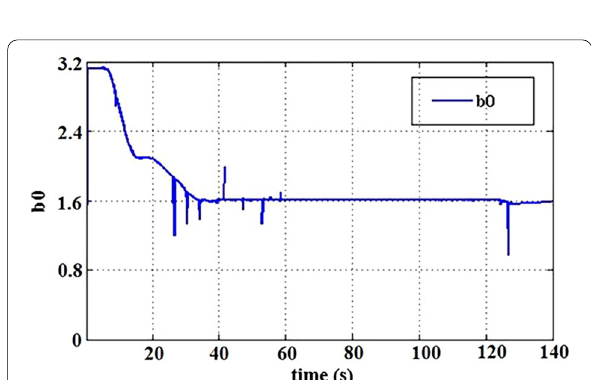
Figure 7 Adjustment process for the control parameter b 0